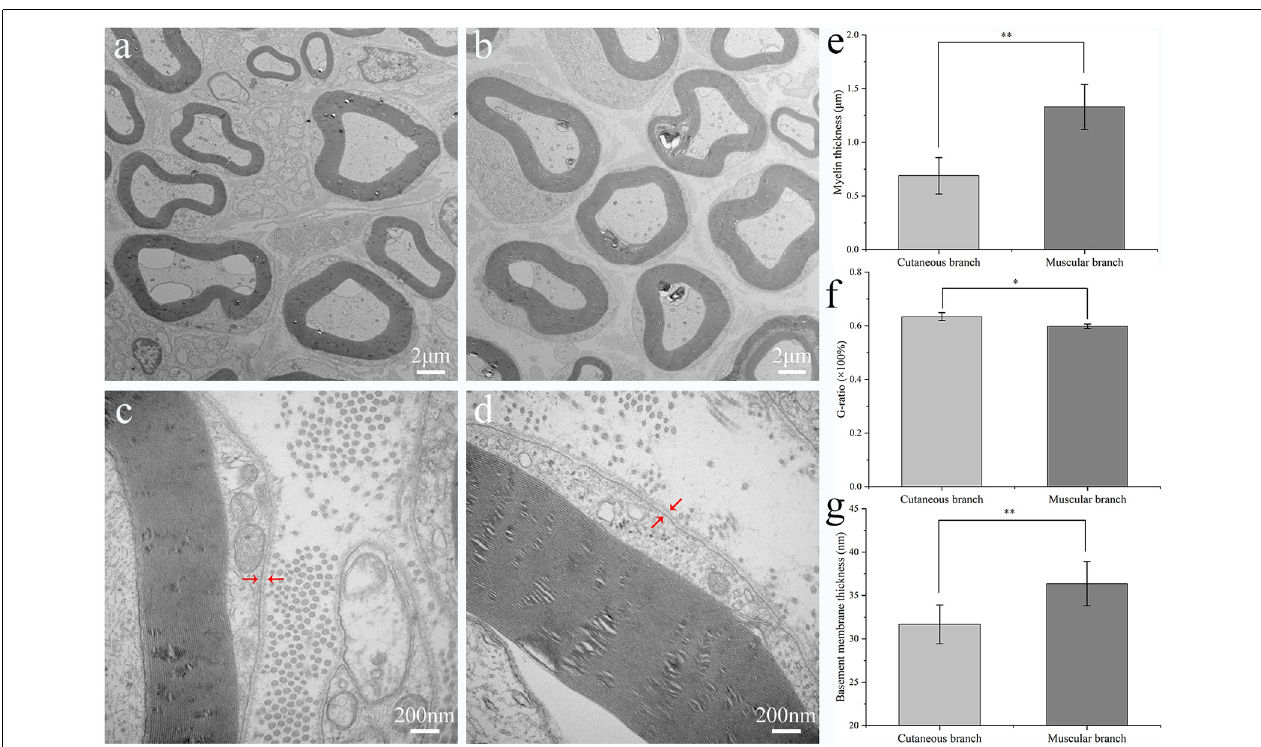
FIGURE 2 | Ultrastructural evaluation of the rat femoral branches. Transmission electron microscopy of transverse ultrathin sections of the cutaneous branch (A,C) and muscular branch (B,D) of the rat normal femoral nerve. Arrowheads in (C,D) indicate the basement membranes of the femoral nerve branches. Mean thickness of the myelin sheath (E) , the value of G-ratio (F) and basement membrane (G) of the cutaneous and muscular branches of the rat normal femoral nerve. Wilcoxon rank-sum test was used in (E) , and independent-samples t -test were used in (F) and (G) , respectively. ∗∗ p < 0.01, ∗ p <